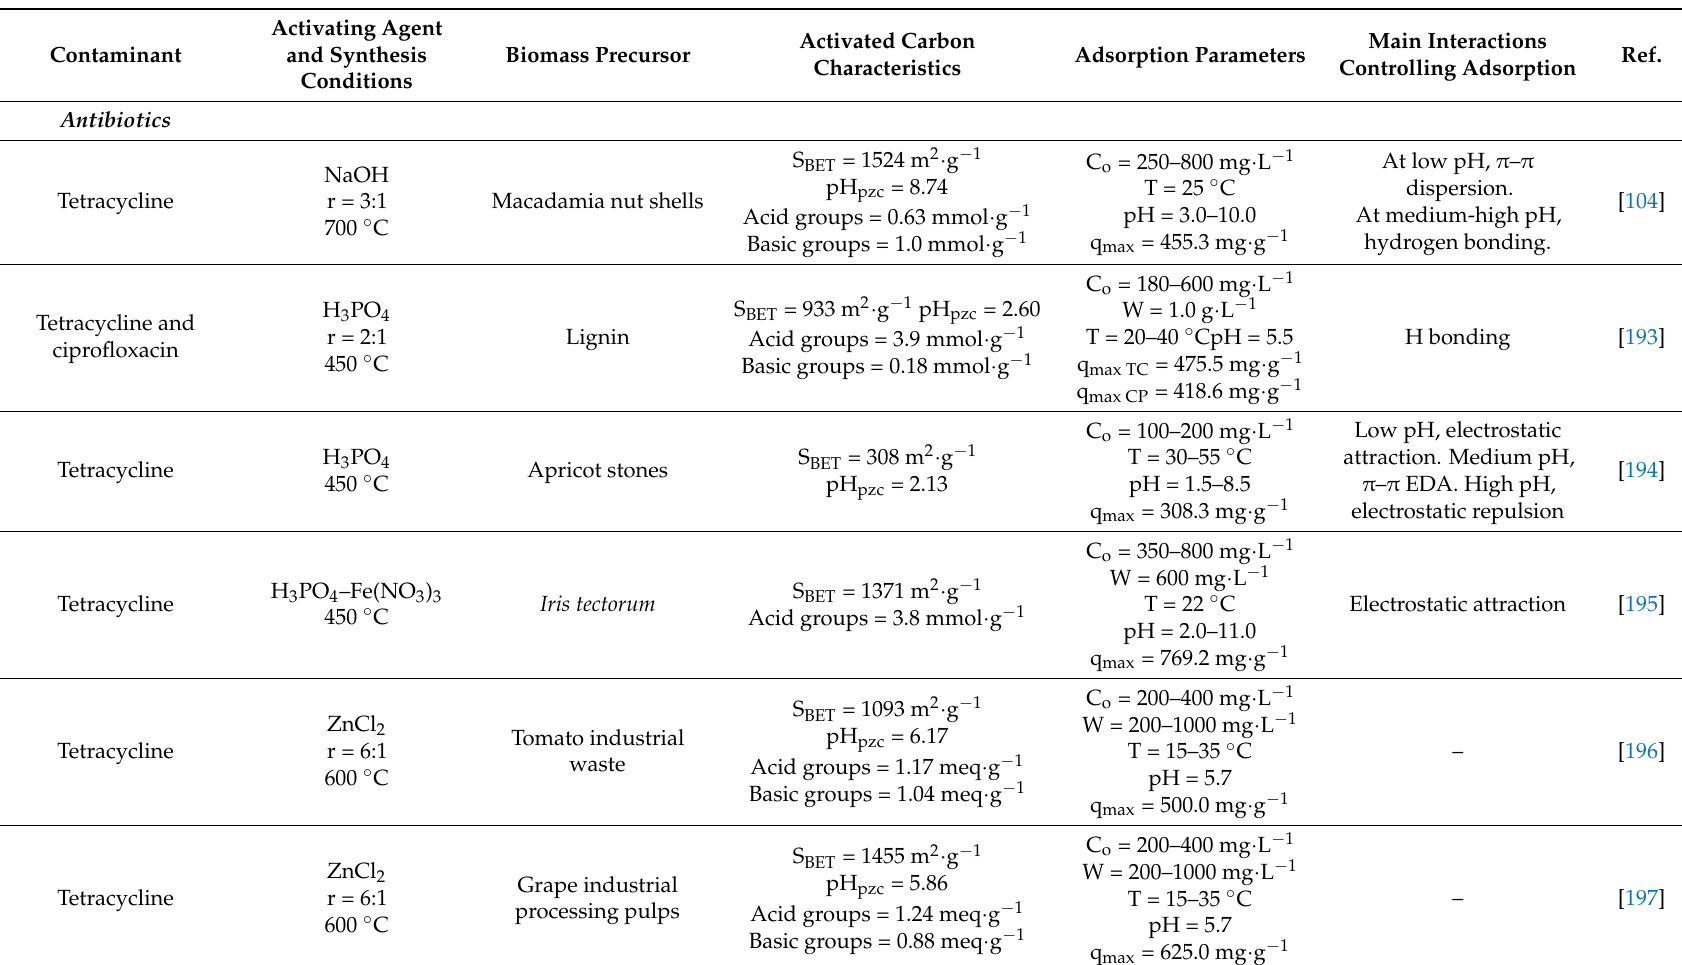
Table 6. Summary of representative works in the literature on adsorption of emerging contaminants from water with biomass-derived activated